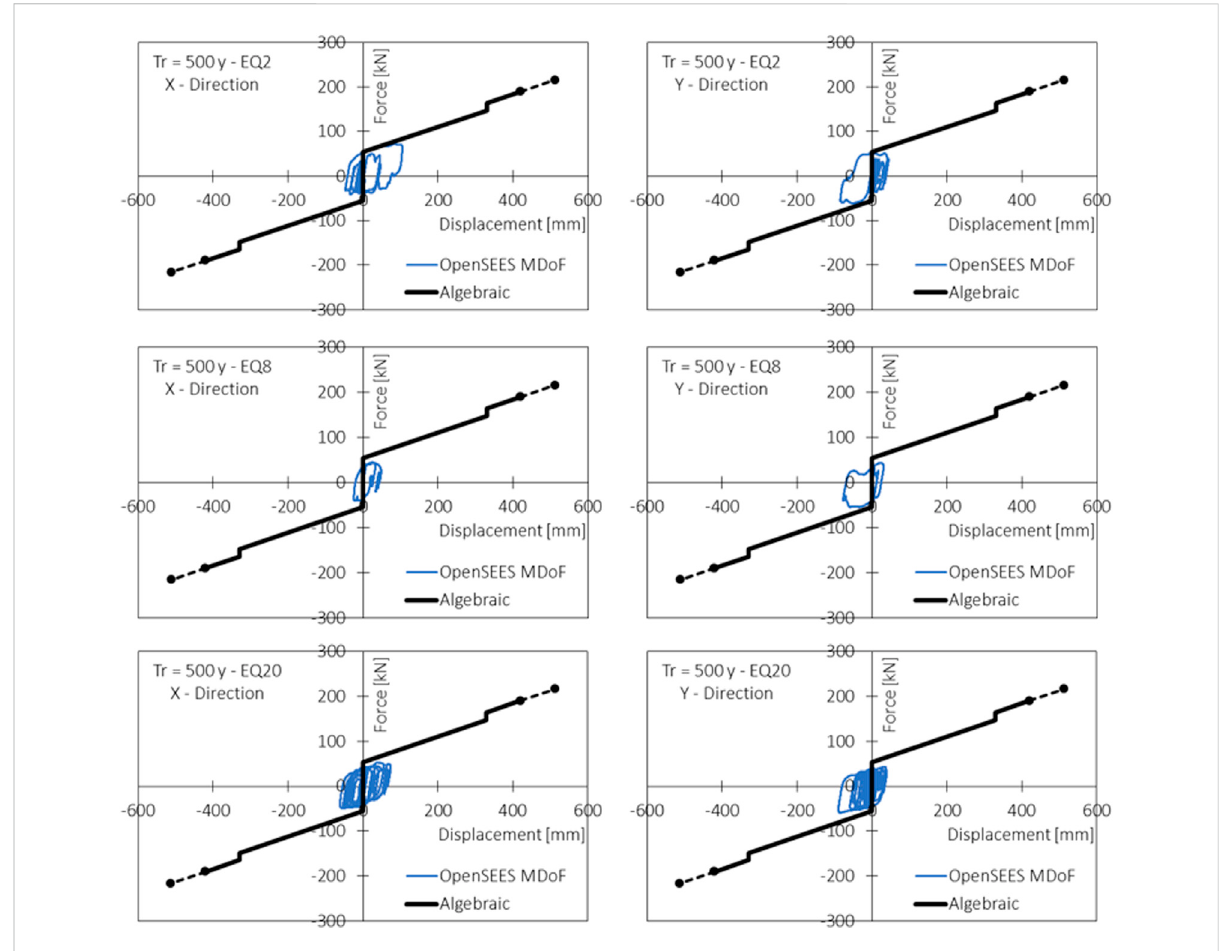
FIGURE 11 Single DCCSS bearing force vs. displacement relationship in X and Y directions for three example earthquakes (EQ2; EQ8; EQ20 for a return p oferiod 500 years.